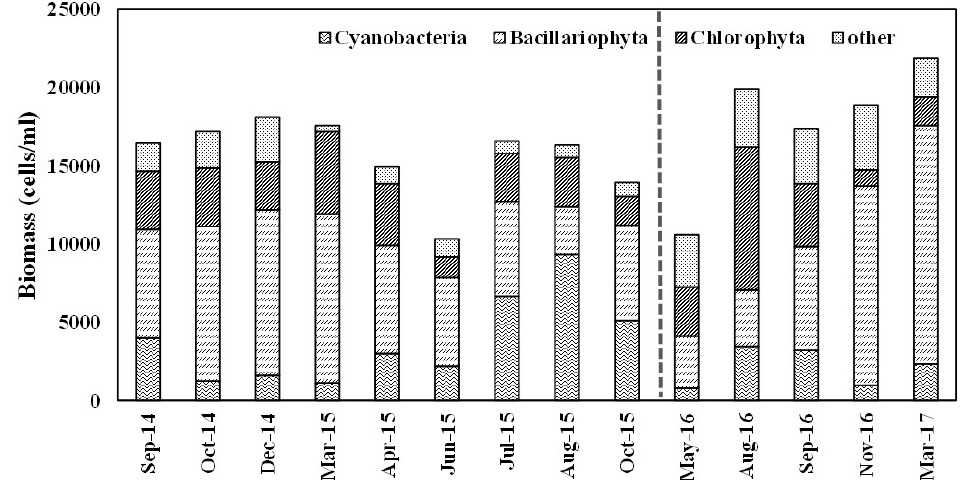
Figure 8. Temporal distribution of cell concentrations of taxonomic groups of phytoplankton. Values depicted are average values of data measured in seven sampling locations.